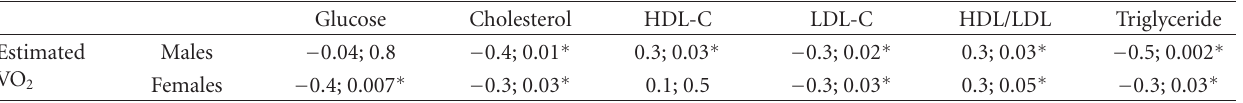
Table 5: Estimated maximum VO 2 relationship with blood glucose and lipid profile in the males and females.